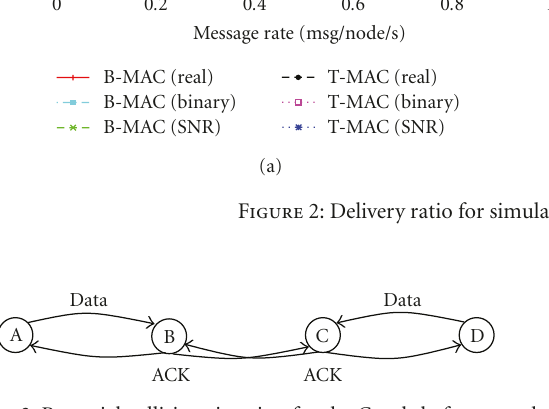
Figure 3: Potential collision situation for the Crankshaft